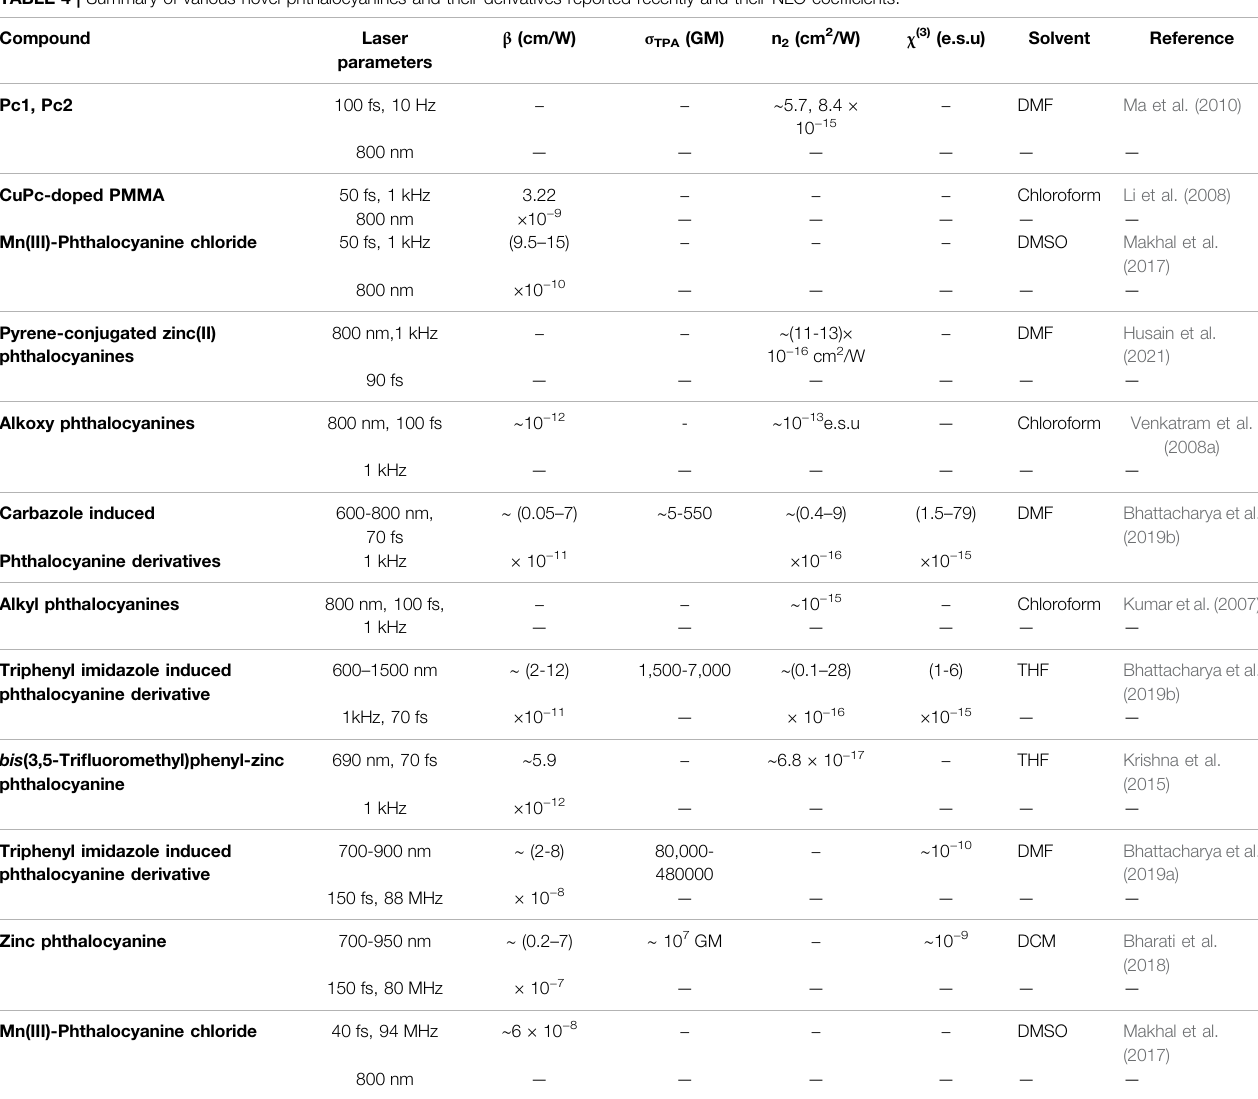
TABLE 4 | Summary of various novel phthalocyanines and their derivatives reported recently and their NLO coef fi cients. Compound